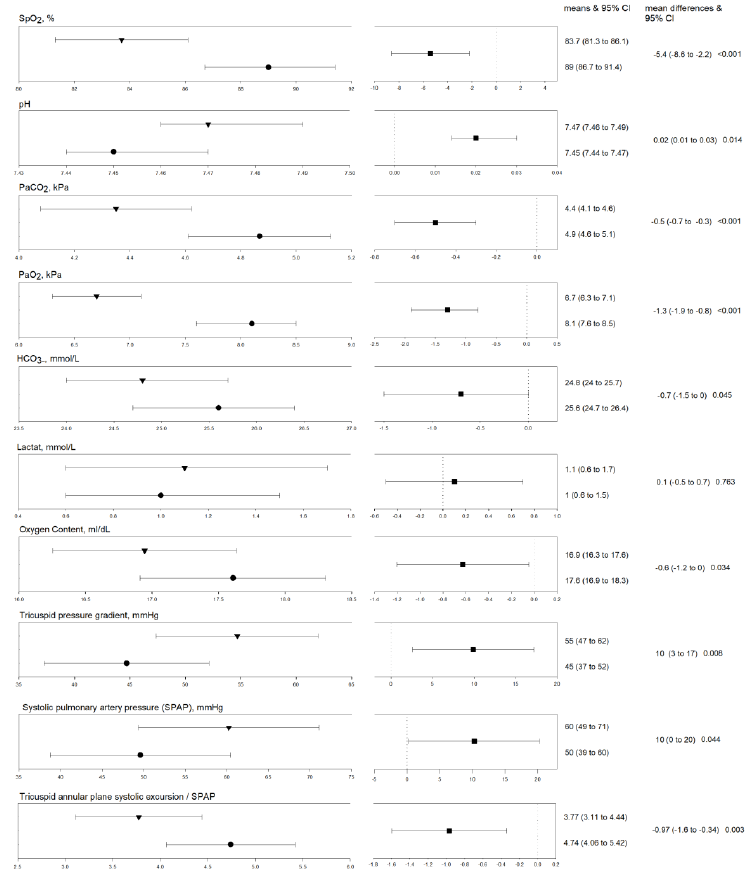
Figure 3. Physiological outcomes after 20–30 min under normobaric (F i O 2 : 15%) vs. hypobaric hypoxia (2500 m). Triangles and circles indicate mixed-effect model derived means and 95% confidence intervals (CI) of outcomes during normobaric hypoxia (F i O 2 : 15%) and hypobaric hypoxia (2500 m) after 20 – 30 min of exposure. Fixed effects variables are Time, Age, Gender and New York Heart Association class and random effect is the subject ID. Cubes indicate the mixed- effect model derived mean-differences with associated 95% CI.